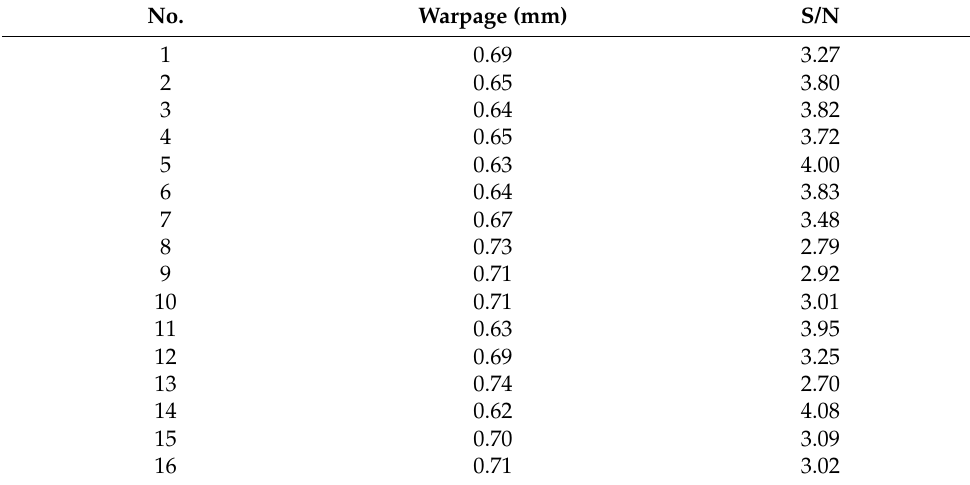
Table 6. S/N Ratios of Total Warpage.